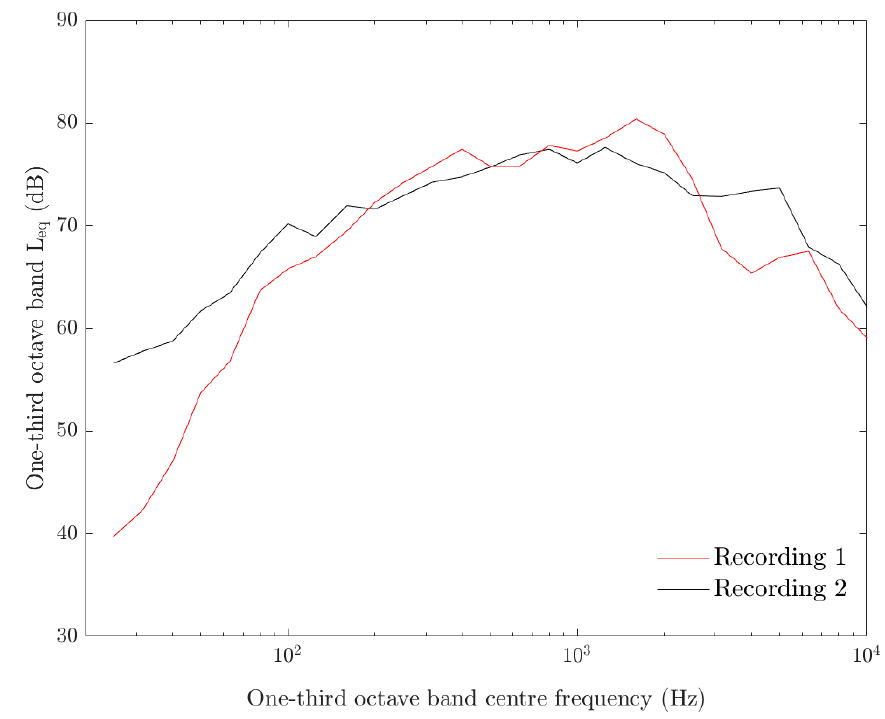
Figure 1. One-third octave band L eq level 1 m in front of the speaker during the continuous noise experiment. Recording 1 (black), recording 2 (red).